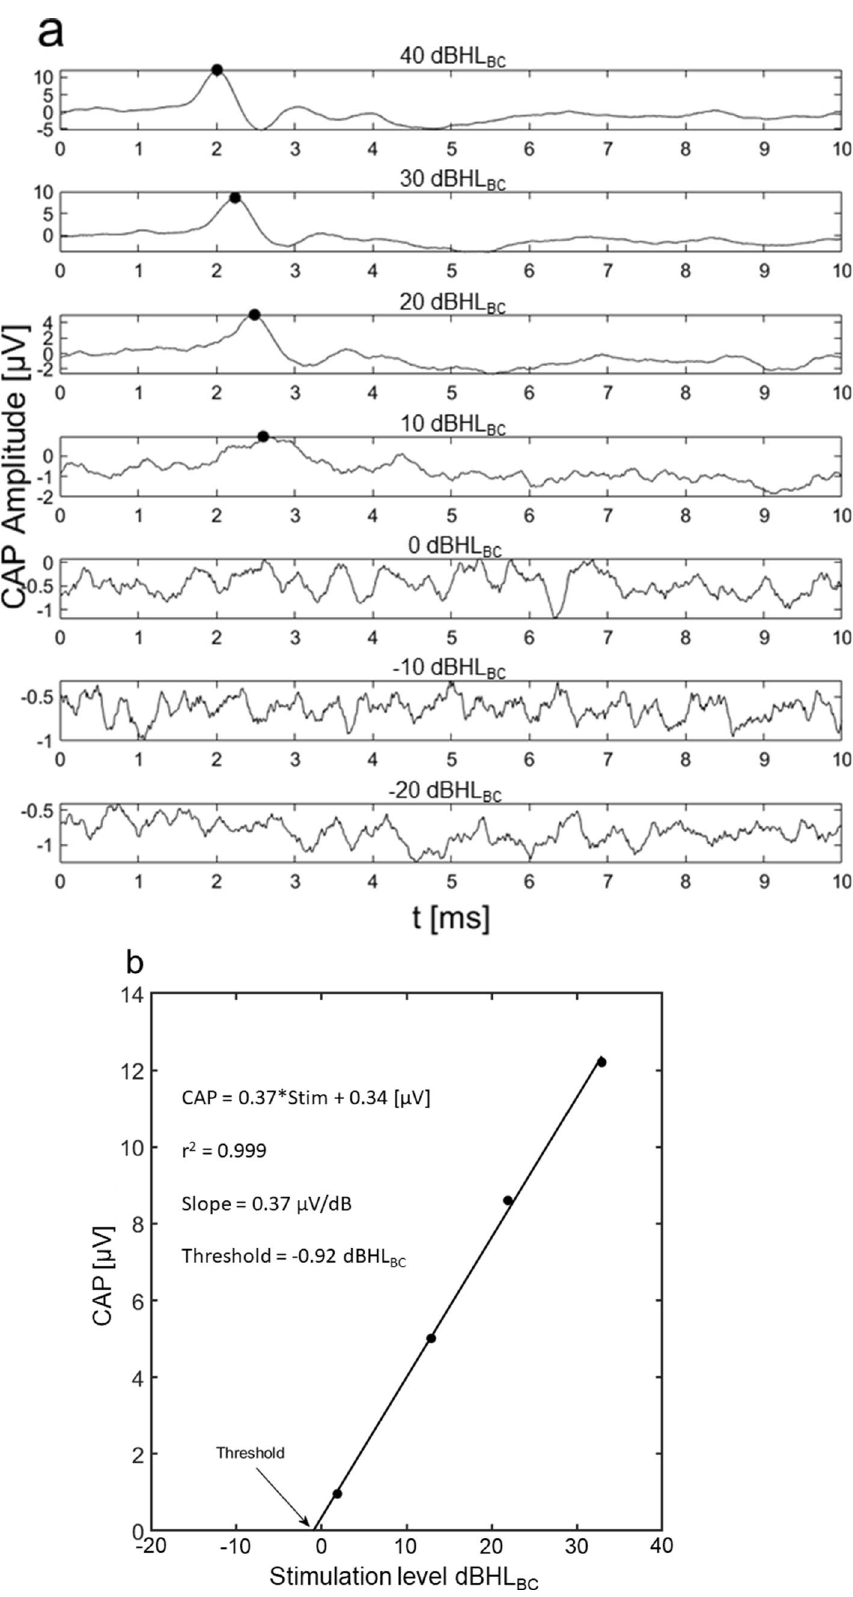
Figure 7. CAP measurements in the guinea pig. ( A ) A typical result of CAP measurement with BC stimulation. The peak voltage used for the analysis is indicated with a dot on the amplitude traces. ( B ) An example of the regression calculation used to obtain the threshold levels. The current example is for a stimulation frequency of 8